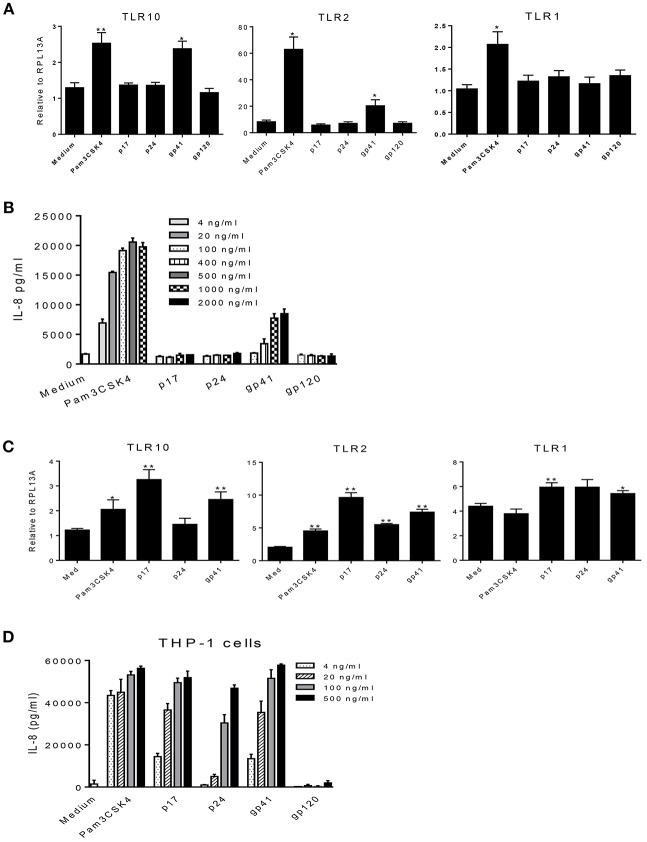
Effects of HIV-1 proteins on TLR expression and cellular responses. (A) MCF-10A cells were treated with Pam3CSK4 and the HIV-1 structural proteins: p17, p24, gp41, and gp120. Cellular TLR10, TLR2, and TLR1 mRNAs were analyzed by qRT-PCR. (B) IL-8 production in cell culture supernatants in the presence of different concentrations of Pam3CSK4 and HIV-1 proteins were analyzed by ELISA. (C) The expression of TLR mRNAs analyzed by qRT-PCR in THP-1 cells treated with Pam3CSK4 and the HIV-1 structural proteins: p17, p24, and gp41. (D) IL-8 production in THP-1 cell culture supernatants in the presence of different concentrations of Pam3CSK4 and HIV-1 proteins was analyzed by ELISA. Data set is representative of three different experiments completed in triplicate. Statistic marks: *p < 0.05, **p < 0.01 for the Mann-Whitney t-tests, each group was compared to the medium-treated group (Medium).